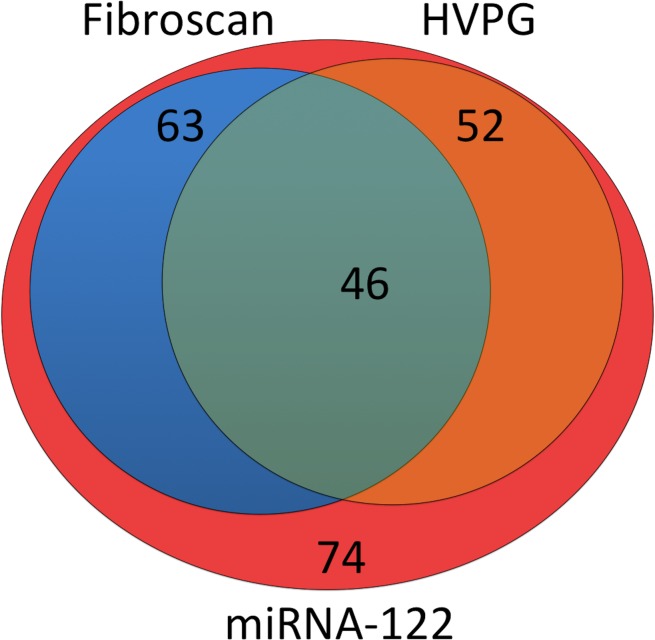
The Venn-diagram depicts the number of patients receiving HVPG-measurements and fibroscan.Circulating miRNA-122 levels were measured in seventy-four patients with HIV/HCV coinfection. Hepatic venous pressure gradient (HVPG) was measured in fifty-two patients. The fibrosis stage was determined using transient elastography in 63 patients.